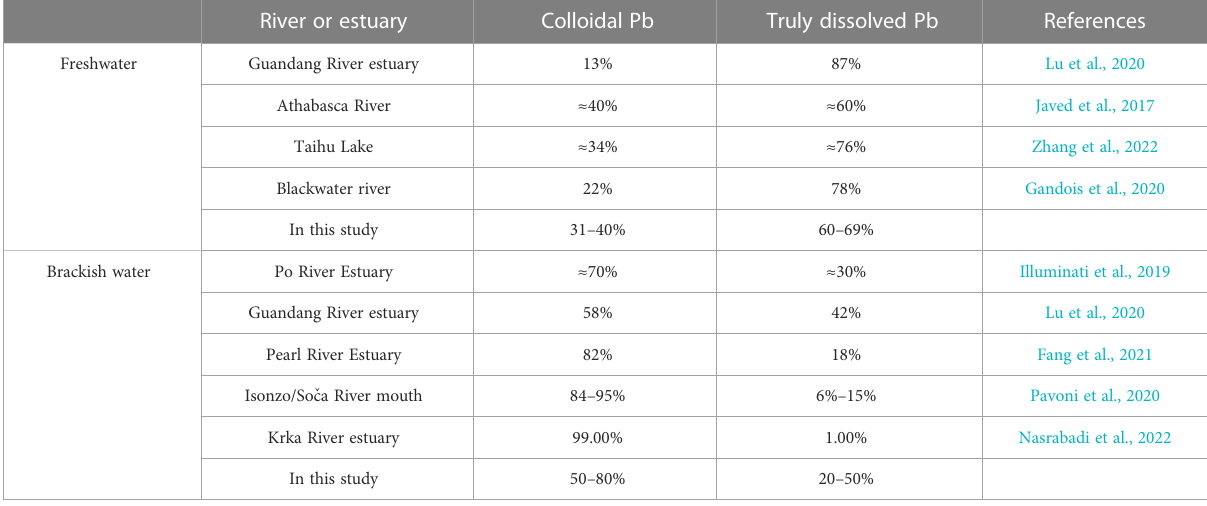
TABLE 4 The concentration of lead (Pb 3 ) in the truly dissolved and colloidal phases in different river fl ows into the